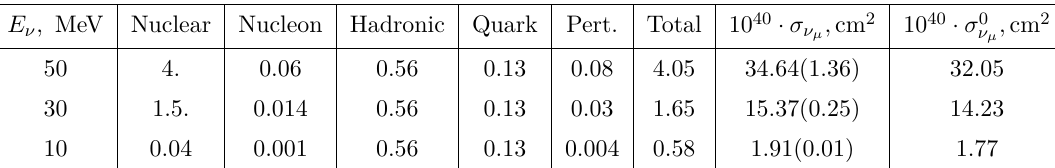
is compared to ν µ